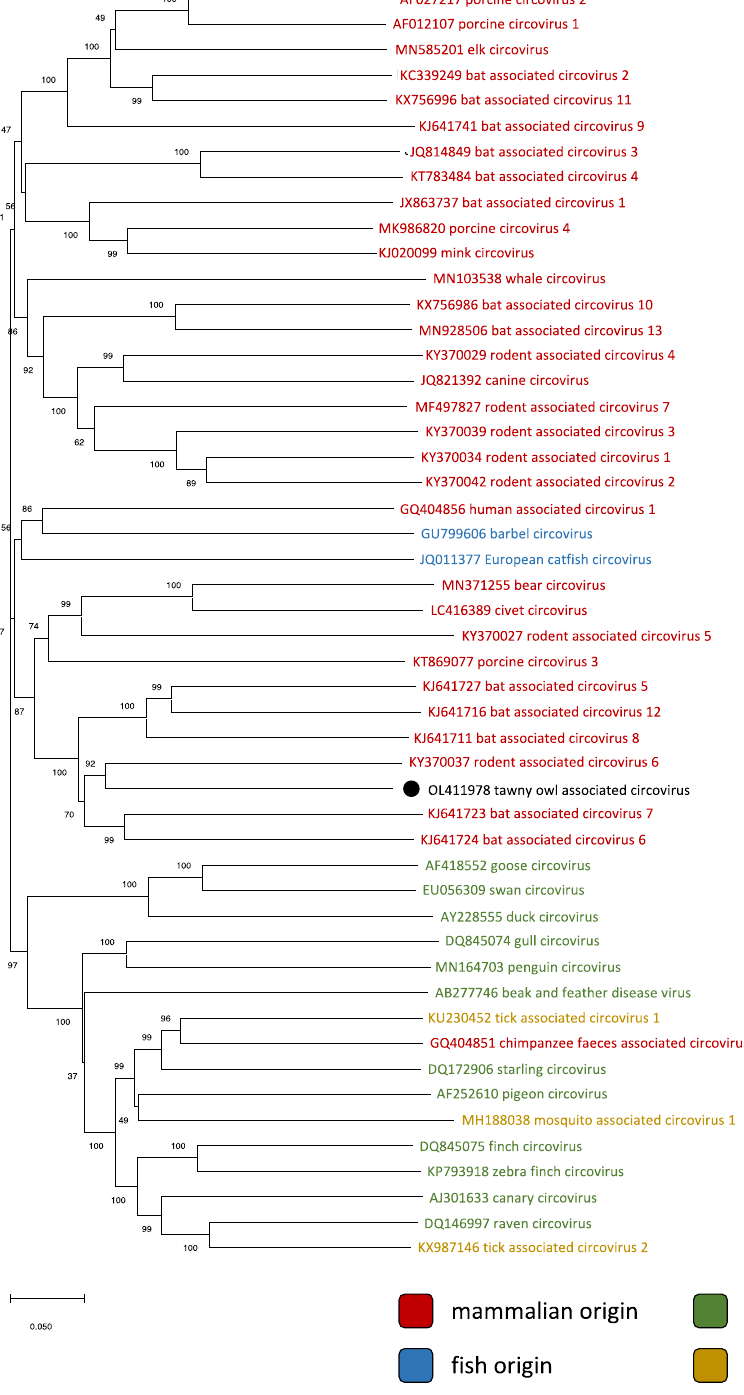
Figure 1. Phylogenetic relationships between the tawny owl-associated circovirus (marked with a black dot) and representatives of every known species of circovirus, whose names were color-coded based on origin. The tree was inferred using the Neighbor-Joining method [27] with pairwise deletion. The percentage of replicate trees in which the associated taxa clustered together in the bootstrap test (1000 replicates) are shown next to the branches [28].